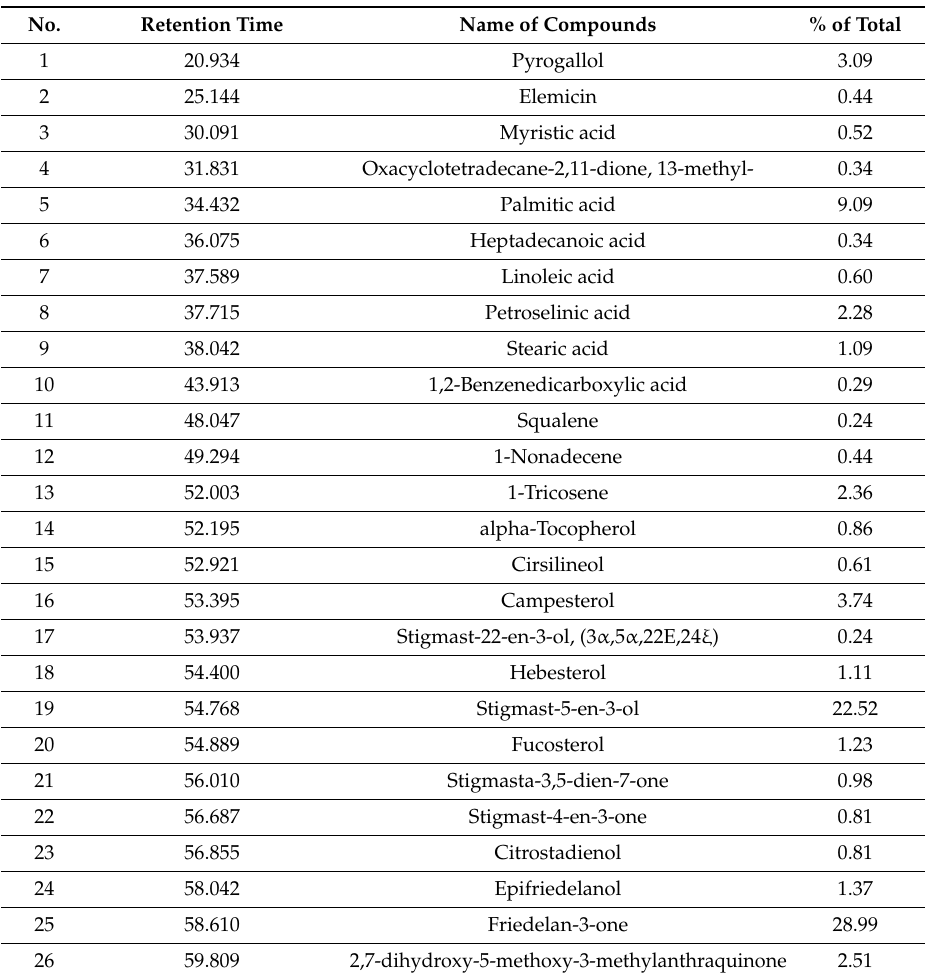
Figure 3. GC-MS chromatograms of the bioactive compounds are presented from the effective extracts. The four effective extracts were analyzed using Agilent Technology 7890A GC interfaced with Agilent technology 5975C (EI) MS. Their identification and characterization were based on their elution order in a DB-5MS column. The chemical structures of three major compounds in ( A ) BEA, ( B ) CEA, ( C ) EEA, and ( D ) EE are presented. Table 2. Retention time, name, and percentage of the total of the enabling identification compounds from BEA.